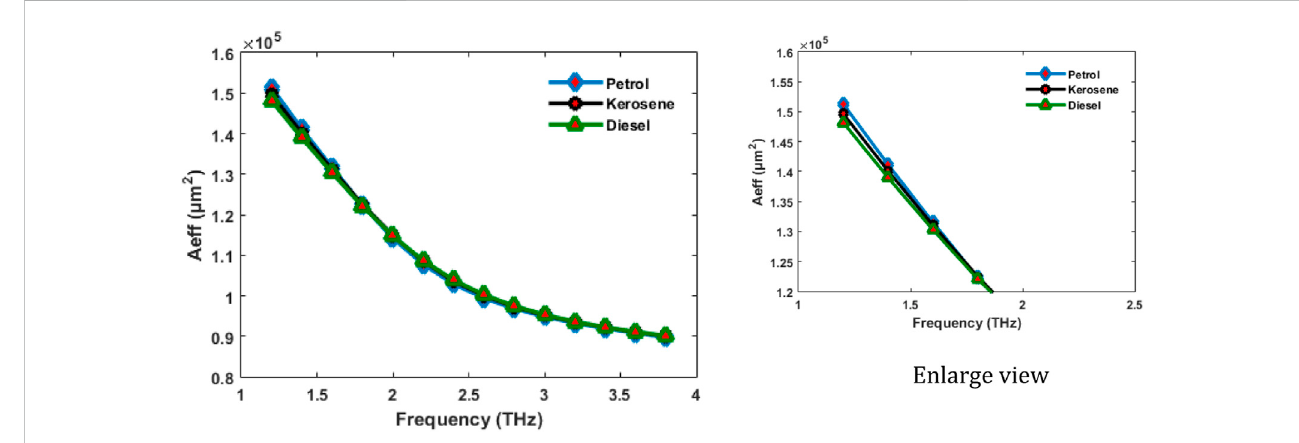
FIGURE 7 Effective Area vs. operating frequency.